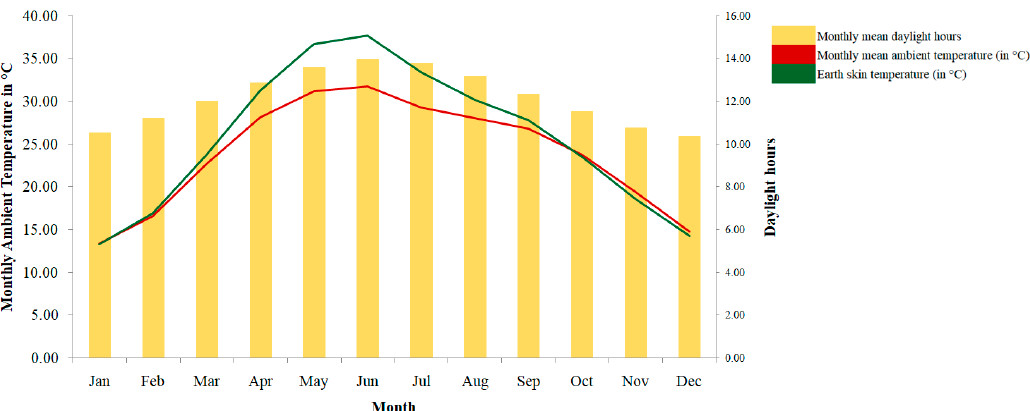
Figure 2. Monthly mean ambient temperature, earth skin temperature, and daylight hours of the selected site.